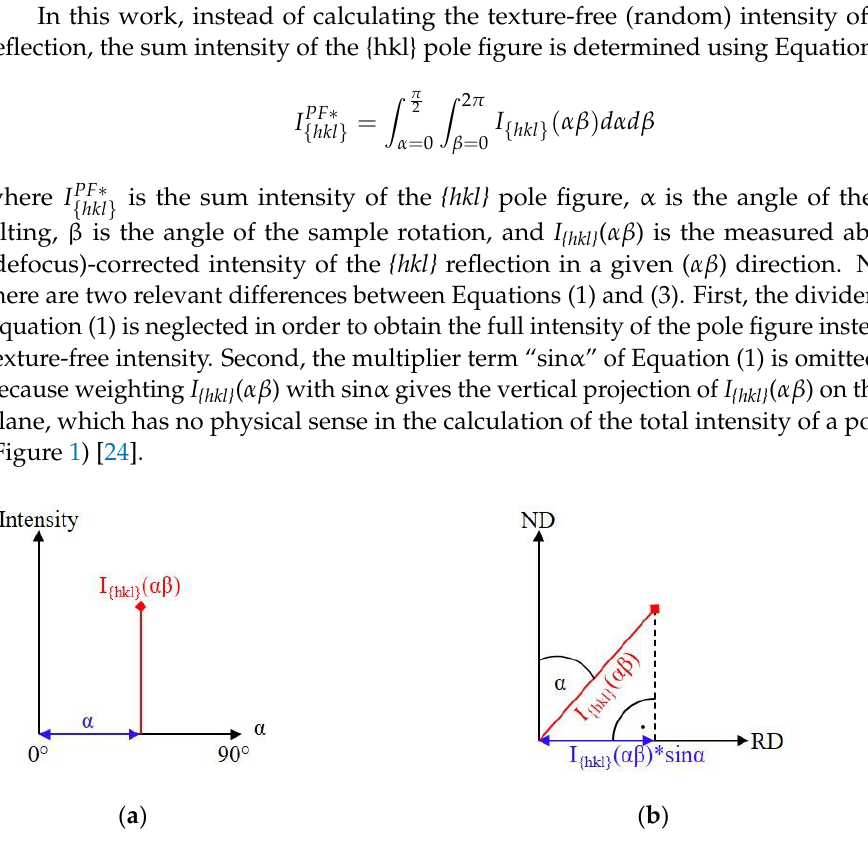
Figure 1. Intensity measured at the tilting angle α at rotation angle β ( a ) in the pole-figure coordinate system, and ( b ) in the sample coordinate system together with its vertical projection on the rolling plane. RD: rolling direction, ND: normal direction of the sample [24] Reprinted with permission from Marton Benke (2020) Crystallography Reports.